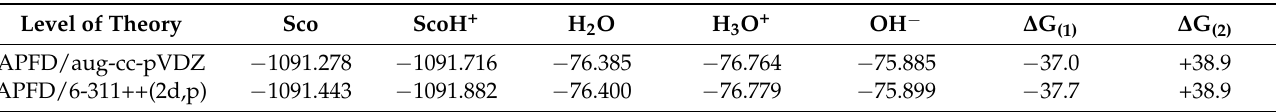
Table 1. T The total electronic energies, corrected for thermal free energies (in the Hartree atomic units, E h ; 1 E h = 627.51 kcal/mol) and the (total) Gibbs free energy changes ∆ G for the two equilibria (in